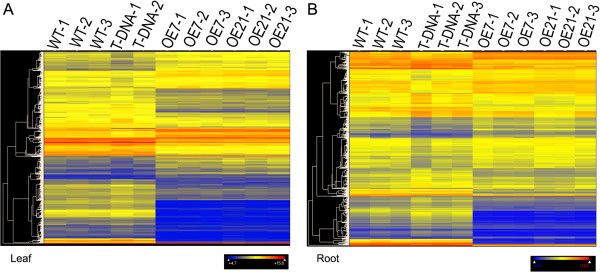
Transcriptional profiling of microarray data in leaves and roots. ArrayStar 3.0 was used to perform heat map clustering. Three replicates (T-DNA line had 2 replicates in the leaves) from the leaves (A) and roots (B) of 20-day-old Arabidopsis were analyzed. The color scale indicates the expression levels. Blue indicates low expression, while red stands for high expression.